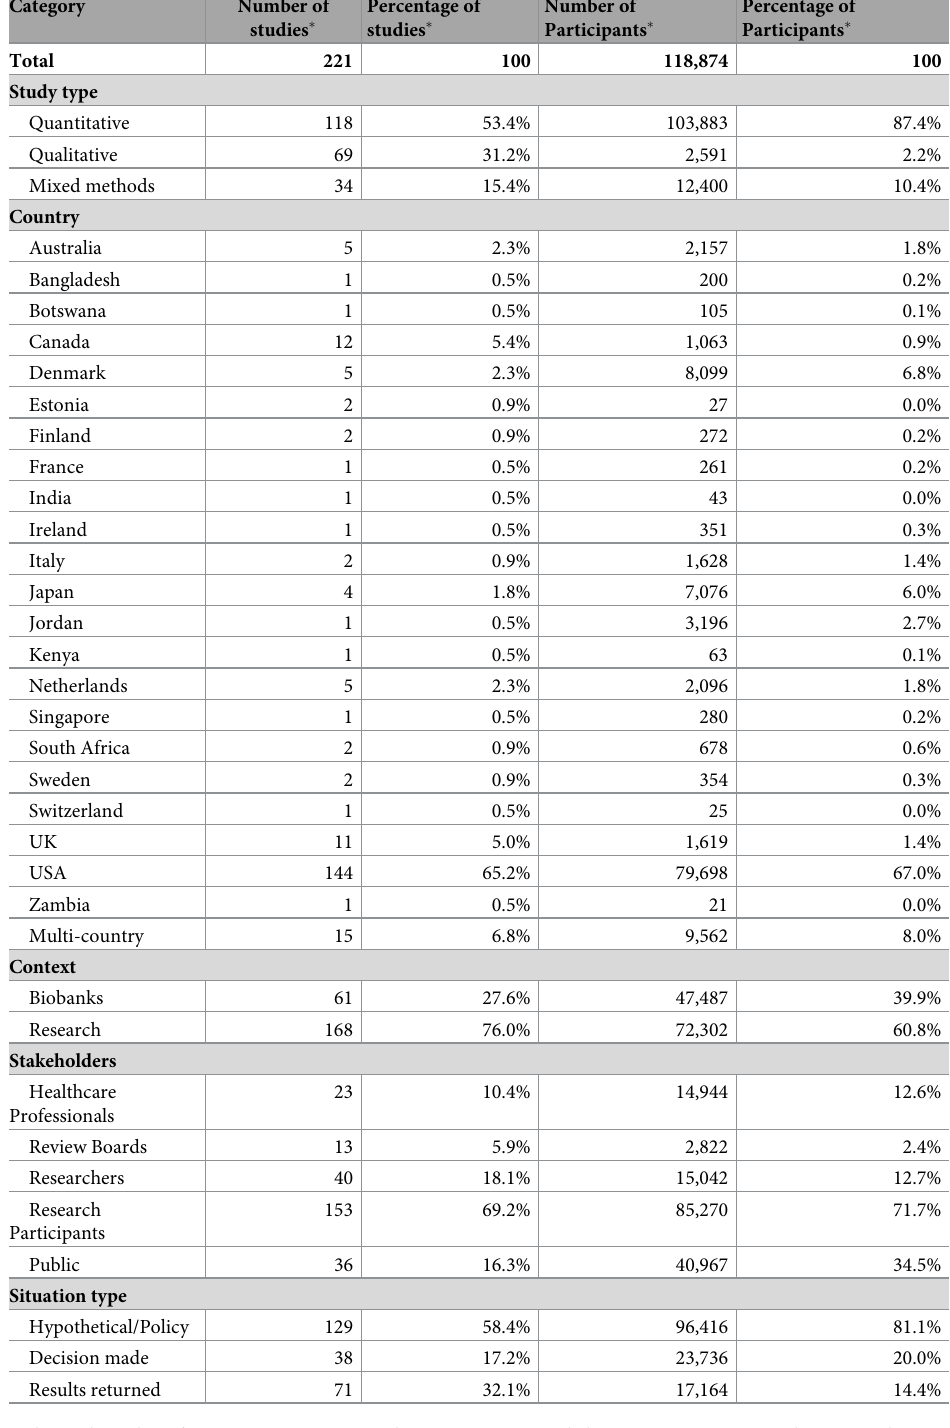
Table 3. Demographics of included